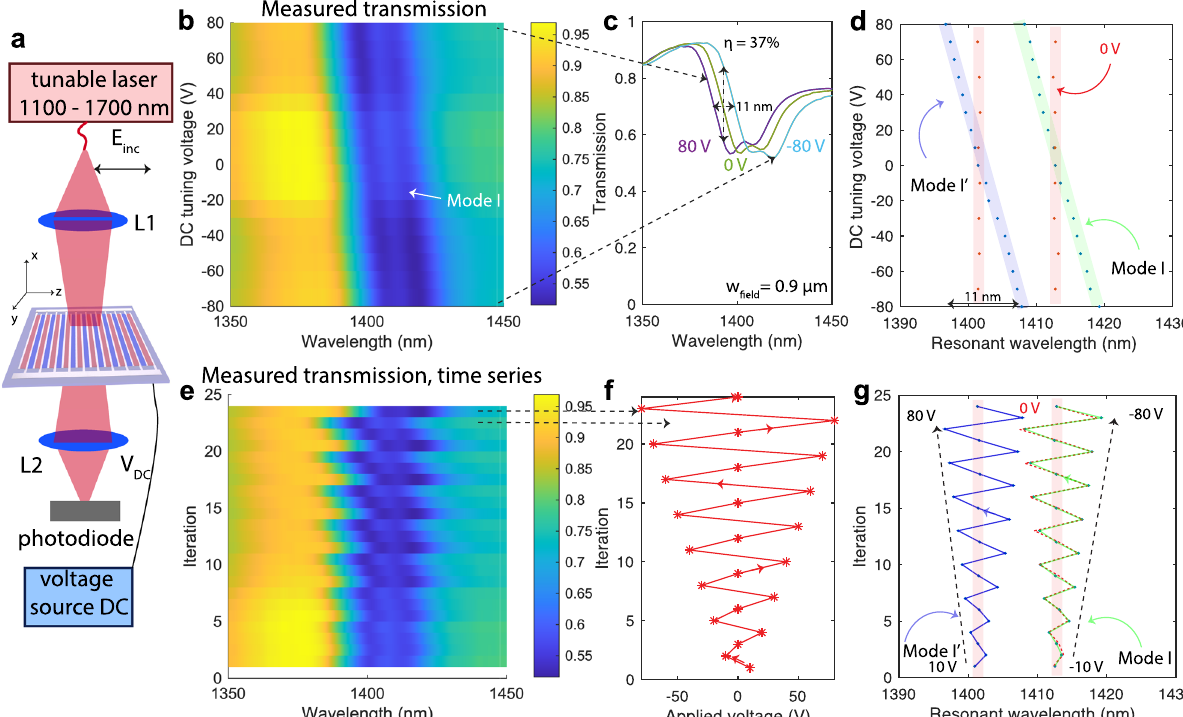
Fig. 3 DC tuning properties of the free-space electro-optic modulators. a Schematic of the experimental setup used to demonstrate the tuning properties of the modulators under a DC voltage. b Measured transmission of a modulator with w fi eld = 0.9 μ m exhibits the expected resonance on mode I. which tunes linearly with the applied DC voltage V DC . c The transmission is reported for three distinct tuning voltages ( − 80, 0, and 80 V) from which we extract ¼ 37 % . d In more detail, mode I. splits into two slightly offset a maximal wavelength tuning of Δ λ res ¼ 11 nm and a maximal modulation depth of η max modes (which we call I. and I.') due to an incident angle θ that slightly deviates from the normal. The resonant wavelengths attributed to mode I. (purple) and I.' (green) are extracted from a . A comparison with several measurements performed at 0 V (red) demonstrate a clear tuning behavior. e – g Tuning behavior of the transmission is analyzed as a time-series where in each iteration, the transmission shown in e , is reported when a tuning voltage as shown in f , is applied (the order of applied voltages is marked by the arrow). In this sequential analysis, we measure the transmission through the substrate each time after cycling the voltage between a positive and a negative value. g Tracking the resonant frequencies of Mode I. (purple) and I.' (green) reveal that even after applying fi elds as high as ±80 V, the modulator goes back to its transmission at 0 V (red) after the applied voltage is disconnected. The resonant wavelength follows the applied voltage (shown as overlay by the red dotted line). Dotted black arrows mark the direction of applied positive and negative voltages. DC direct current. Both L1 and L2 have a focal length of 60 pulse scheme consists of an overall DC voltage offset V o , and an additional RF voltage with V peak = 2 V o , as shown in the inset of Fig. 4a. In Fig. 4e we report an exemplary wavelength-resolved modulation curve for V peak = [ − 80 V, 80 V] at a modulation ¼ 100 kHz, while operating around the reso- frequency f mod nances shown in Fig. 4b. We observe a low-noise modulation (its maximum value is marked with the vertical dashed marker), which switches sign around the resonant wavelength and is strongest where the slope in the transmission curve is highest, as expected. Moreover, it fl ips sign when switching the polarity of the applied modulation voltage, as expected from the exploited Pockels effect, which is linear in fi eld amplitude. From the modulation data, we plot the maximal modulation strength η max for w fi eld = 1 μ m in Fig. 4f, g, and for w fi eld = 0.9 μ m in Fig. 4h, respectively. For the resonances at 1480 nm, 1350 nm and 1160 ¼ 38 % , 28% and nm we report a maximum modulation of η max 40%, respectively. We demonstrate experimentally that a 2 × 2 ¼ 50 MHz SLM device can be operated up to a frequency of f mod where a 3-dB decay of the modulation is observed, marked by the full circles in Fig. 4i. In the Supplementary Note 4F, we provide extensive optical and electronic measurements that show how a series resistance in fl uences the cut-off frequency of the pulser- cable-sample system. Additionally, we derive a simple low- frequency equivalent circuit model loaded with an external